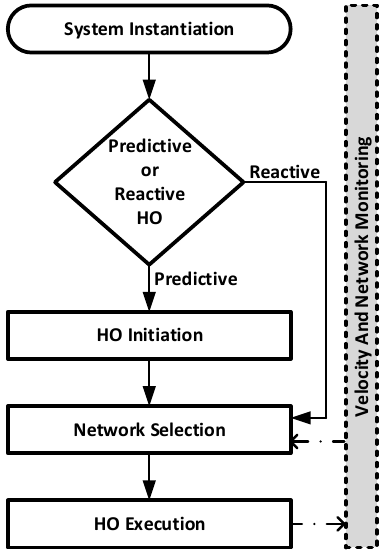
Figure 3. The workflow of the proposed